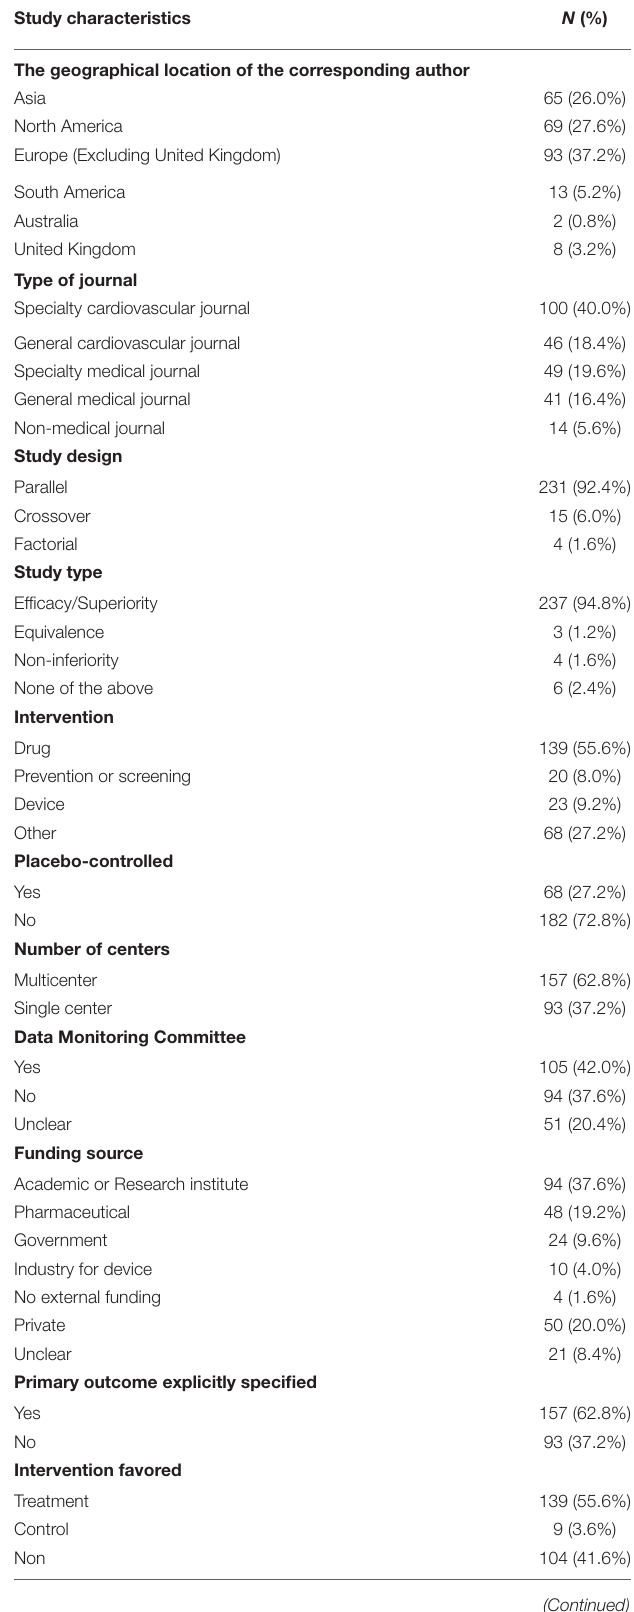
TABLE 1 | Publication and trial characteristics ( N =